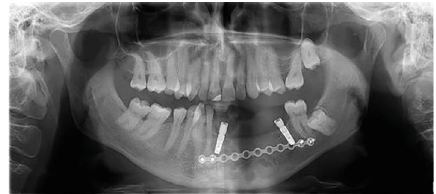
Figure 9: OPG (2020) — 9-year follow-up.